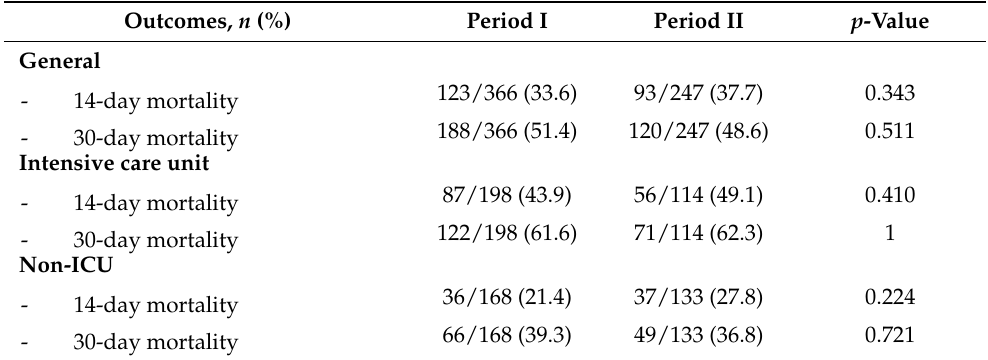
Table 5. Clinical outcomes of adults with candidemia diagnosed at tertiary hospitals in Brazil during Period I: 2010–2011 vs. Period II: 2017–2018 *.